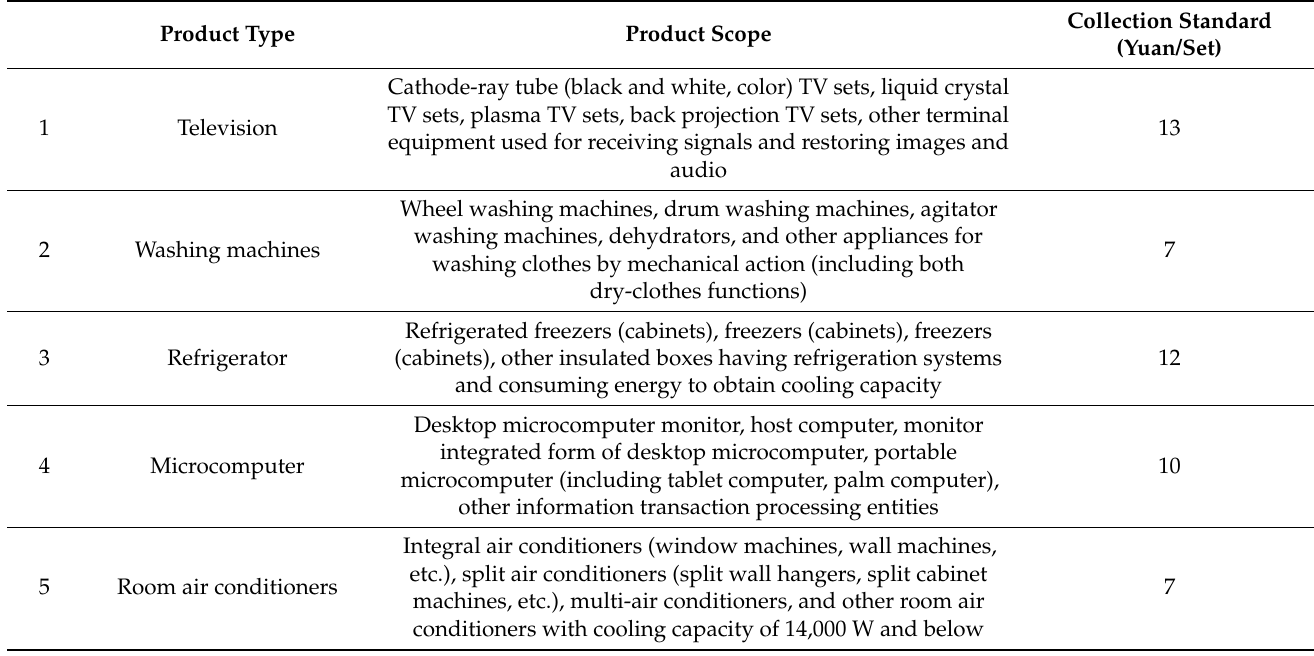
Table 3. Scope and standards of the funds levied by China on enterprises selling EEEs.